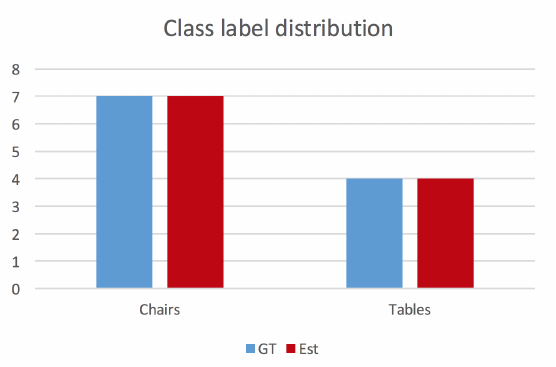
Figure 17. Ground truth and inferred class label distributions for dataset rm4 using the approach of Lan et al. [51].